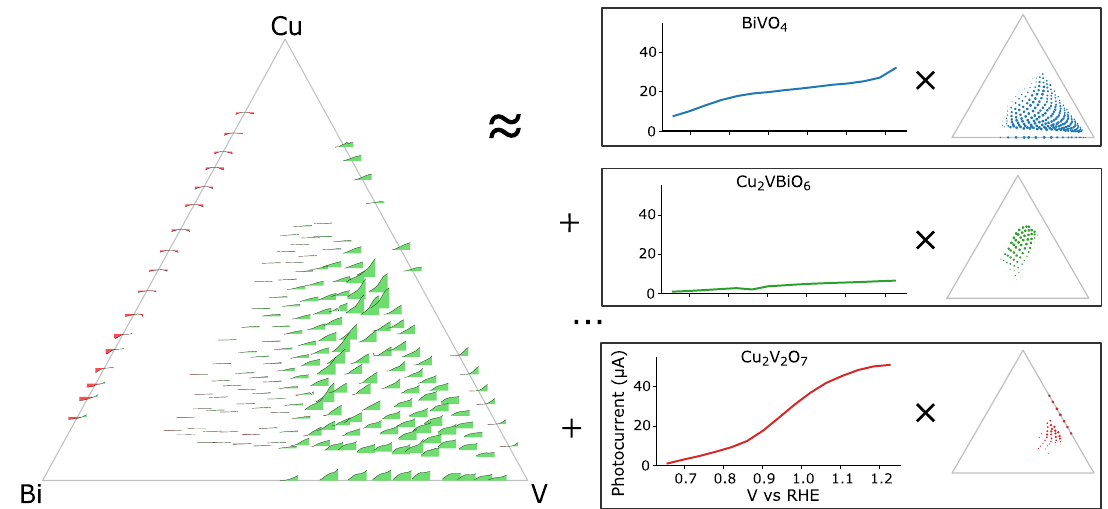
Fig. 2 Illustration of materials structure – property factorization. Representative measured I – E patterns in the Bi – Cu – V oxide composition space are shown with red and green fi ll color indicating negative and positive photocurrent, respectively. This set of photocurrent data is modeled as the sum of contributions for each phase, where the composition map of the contribution of each phase is determined by the product of a representative I – E pattern and the respective phase concentration map from